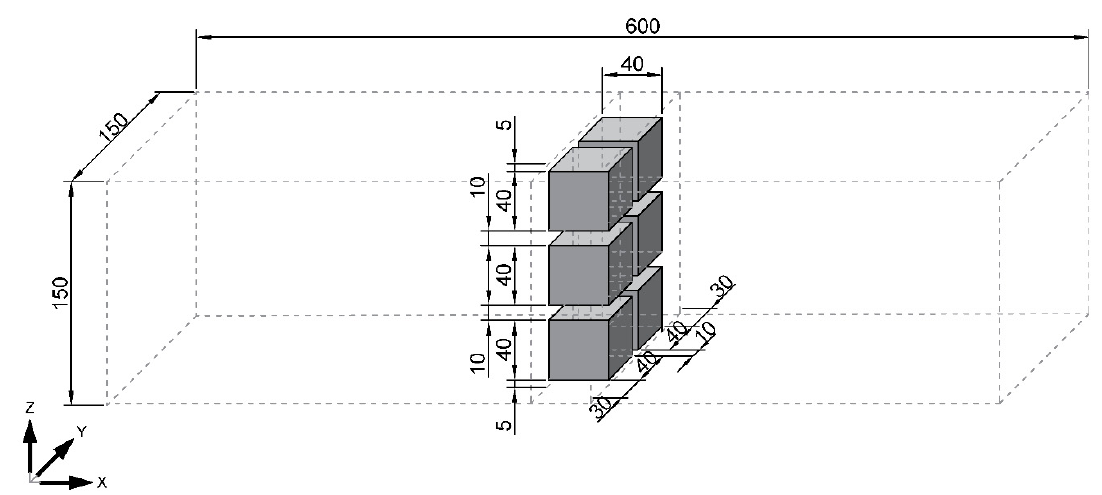
Figure 2. Specimens cut from the prism. Dimensions in mm.